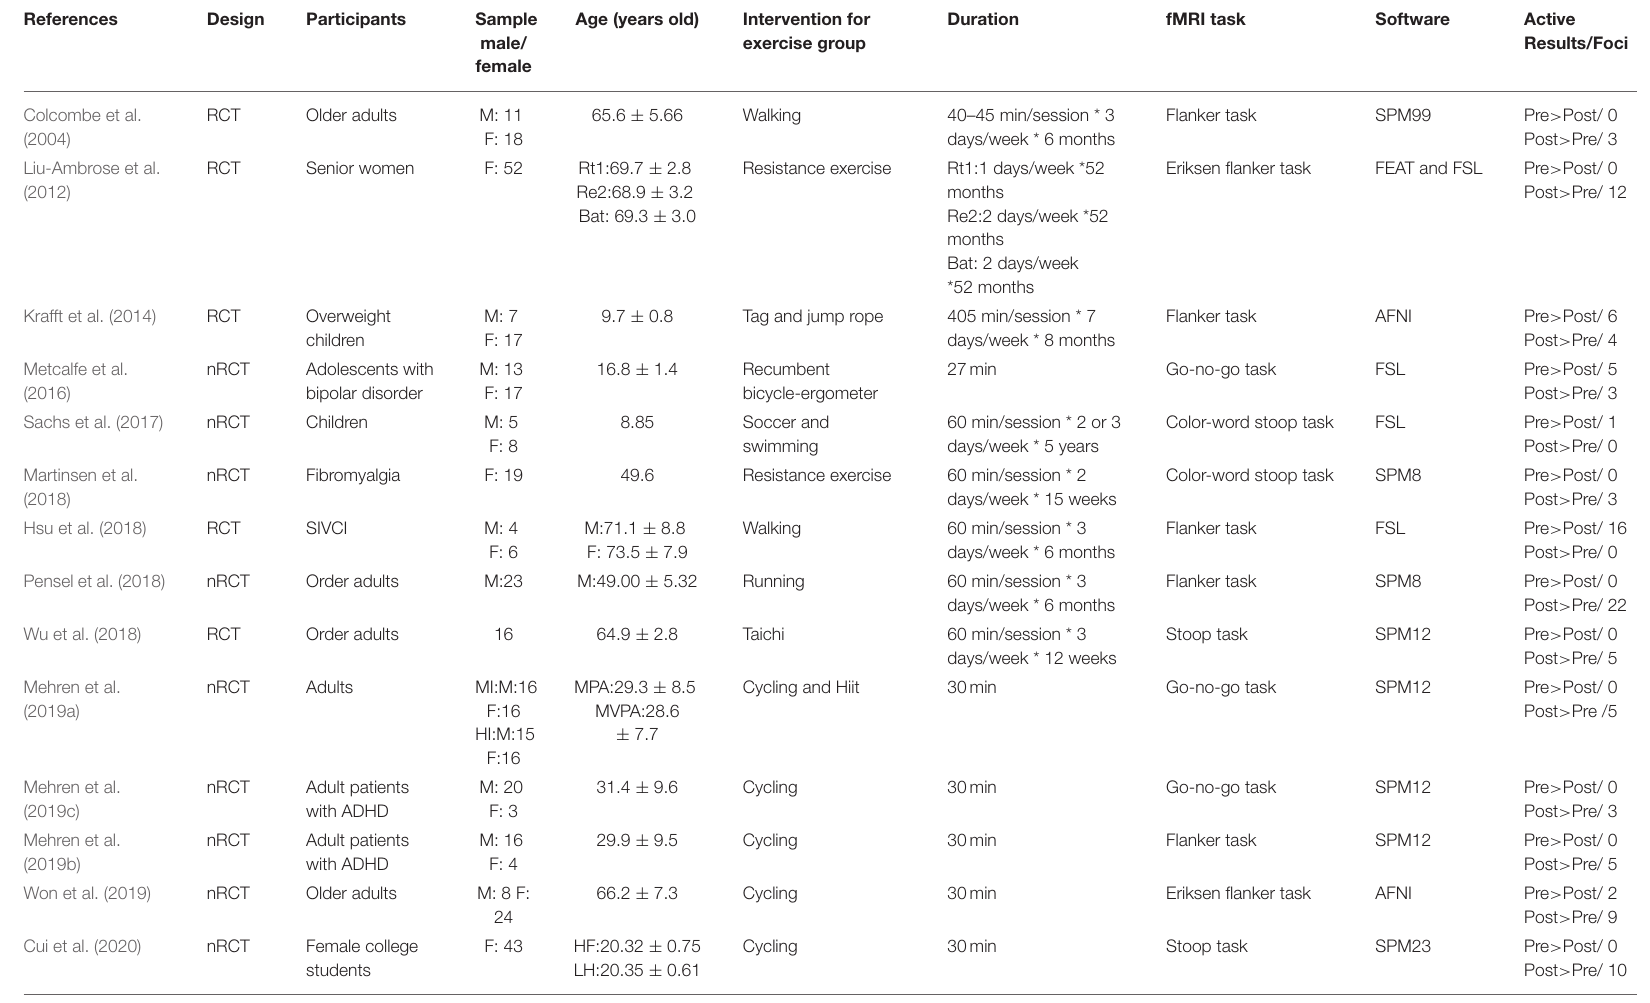
TABLE 1 | Descriptive characteristics of included